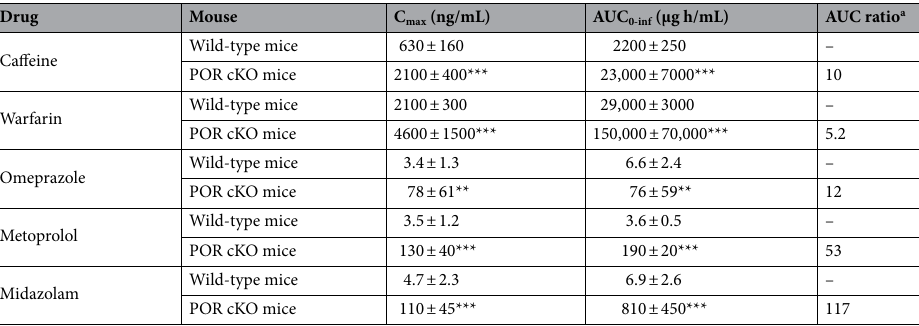
Table 1. Pharmacokinetic parameters for caffeine, warfarin, omeprazole, metoprolol, and midazolam in wild-type mice and POR cKO mice after single simultaneous oral administration (1.0 mg/kg each). a Ratios of AUC 0-inf in POR cKO mice to that in wild-type mice. C max and AUC 0-inf represent the mean ± SD of six animals (wild-type mice) and nine animals (POR cKO mice). ** p < 0.01 and *** p < 0.001 vs. wild-type mice.